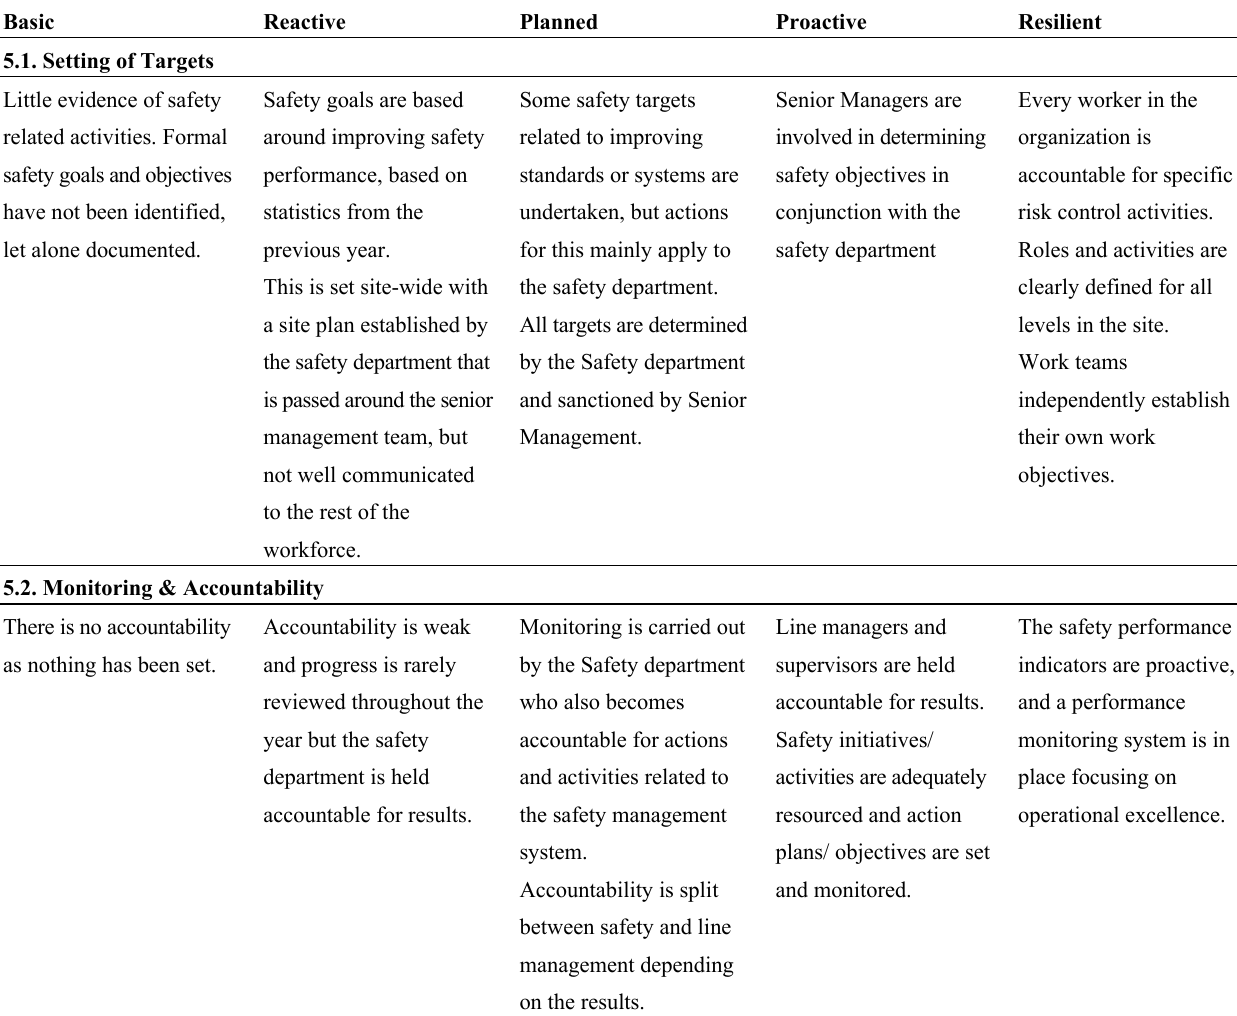
Table 3. Example of question-set related to UK Coal safety way element